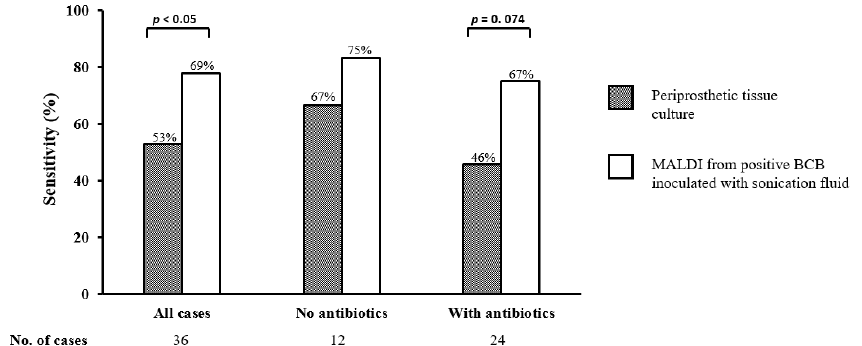
Figure 2. Sensitivity of periprosthetic tissue culture and direct MALDI-TOF MS from sonication fluid inoculated into blood culture bottles in 36 prosthetic joint infections (stratified to whether or not receiving antibiotics prior to sampling).